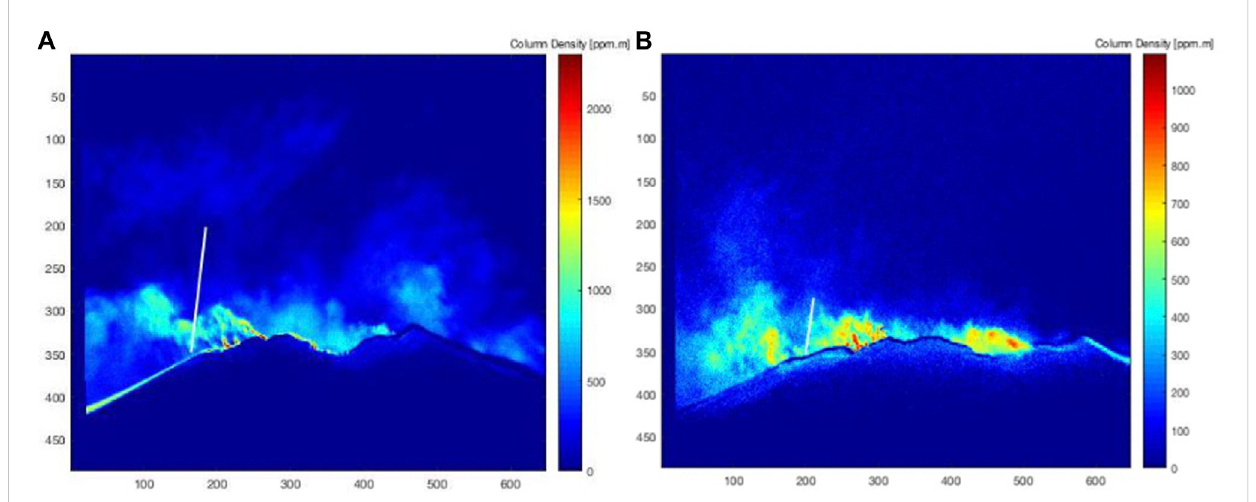
FIGURE 6 ImagesobtainedwiththePiCamUVCameraofLastarriavolcanogasplume,indicatingthetotalSO 2 emissionratesobtainedfromthefourfumarolic fi elds. (A) 17January2019; (B) 21November2019.Thewhitelinescorrespondtocross-plumepro fi lesalongwhichIntegratedColumnAmount(ICA)have (cid:129) been determined. The color bar displays column density in ppm